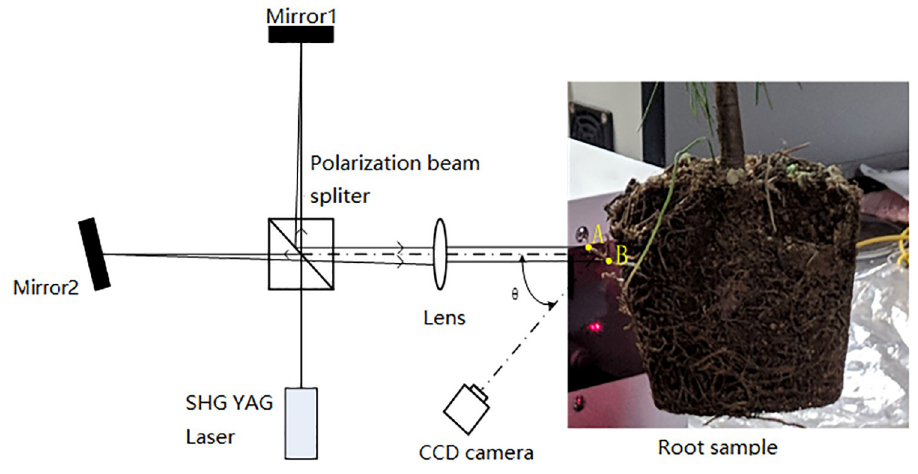
Fig 3. Optical system for root elongation